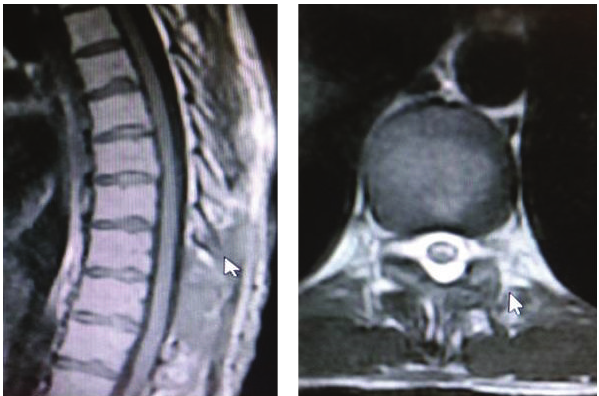
Figure 4: Postoperative thoracic sagittal T1-axial T2 MRI fields marked